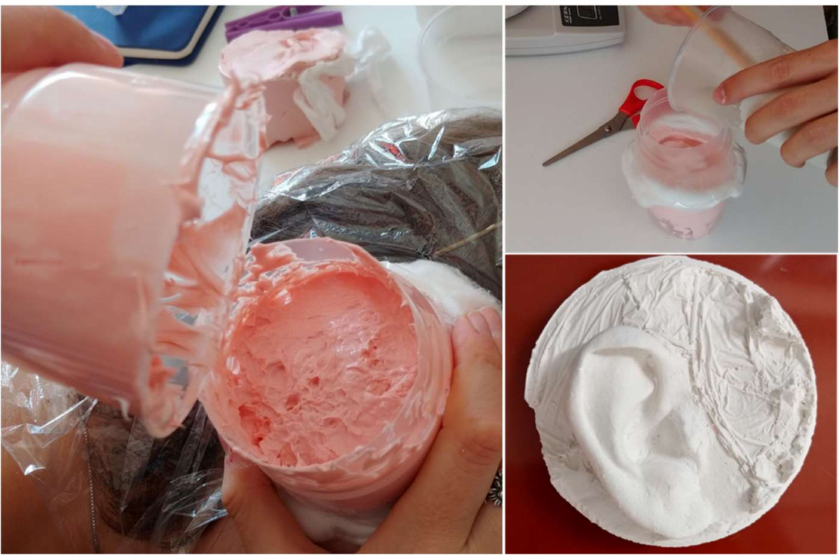
Figure 7. Acquisition of the shape of the ear by means of impression